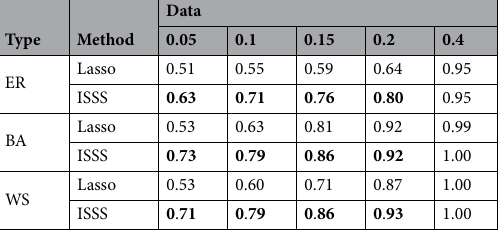
Table 1. Comparison between ISSS and Lasso. We use AUROC 39 (Area under the Receiver Operating Characteristic) index to depict the performance of the inference task. Area is the area under the curve. It is a common summary statistic for the goodness of a predictor in a binary classification task. It is equal to the probability that a predictor will rank a randomly chosen positive instance higher than a randomly chosen negative